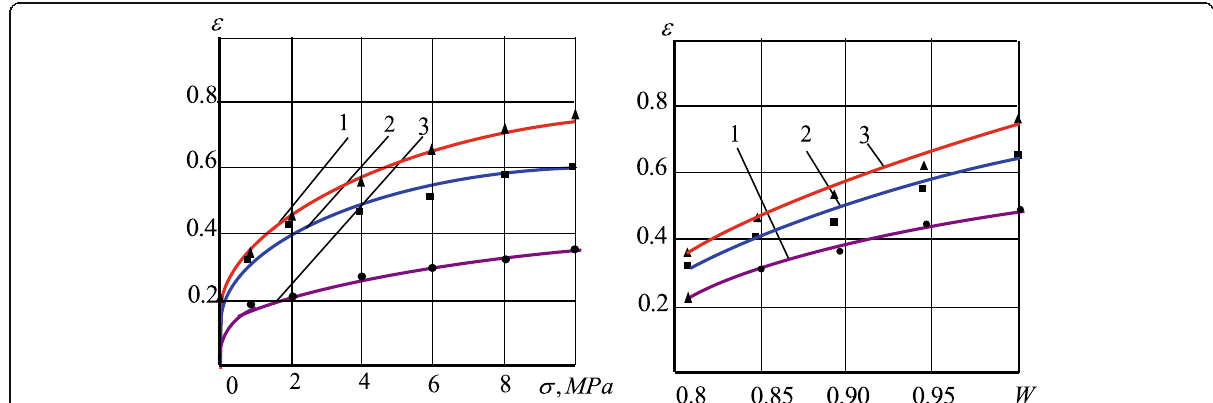
Fig. 4 Dependences of compressive strain ɛ of the butt section on compressive load. σ (1-W = 1; 2-W = 0.94; 3-W = 0.82) and moisture content W